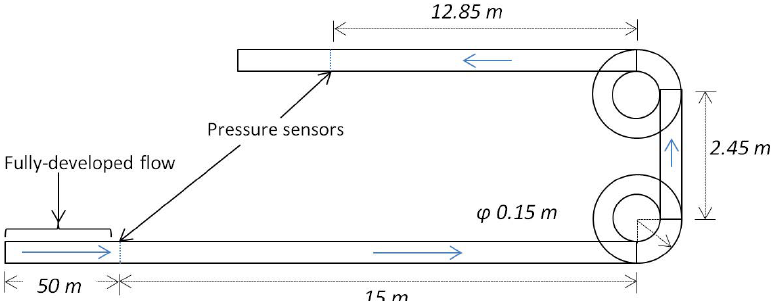
Figure 3. A schematic of a part of the experimental set-up showing the location of the pressure sensors used for validation [1,2] (Courtesy: Stichting